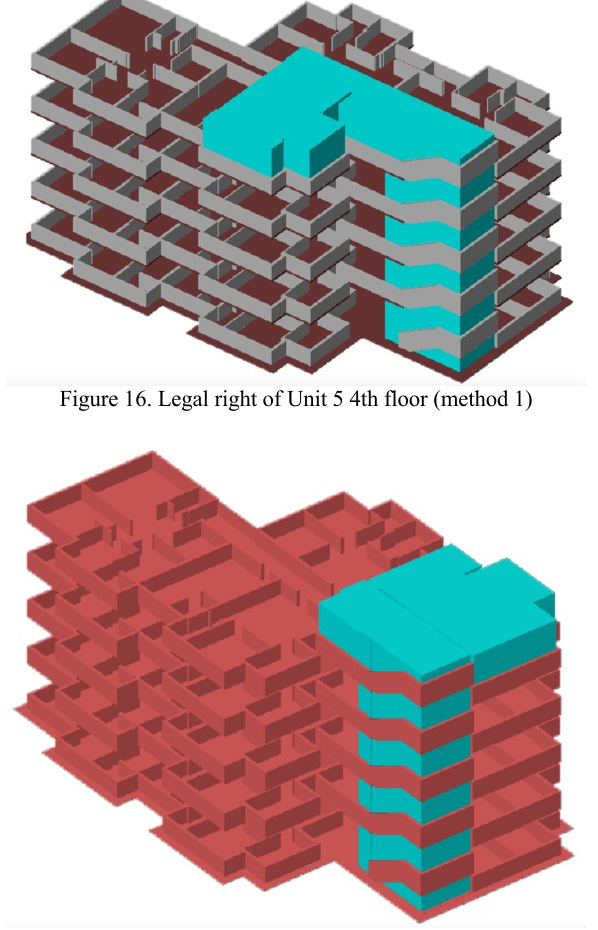
Figure 17. Legal right of Unit 1 4th floor (method 2)